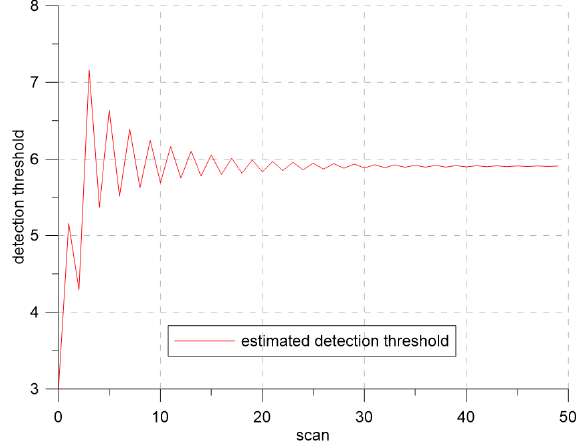
Figure 12. The detection threshold for λ =